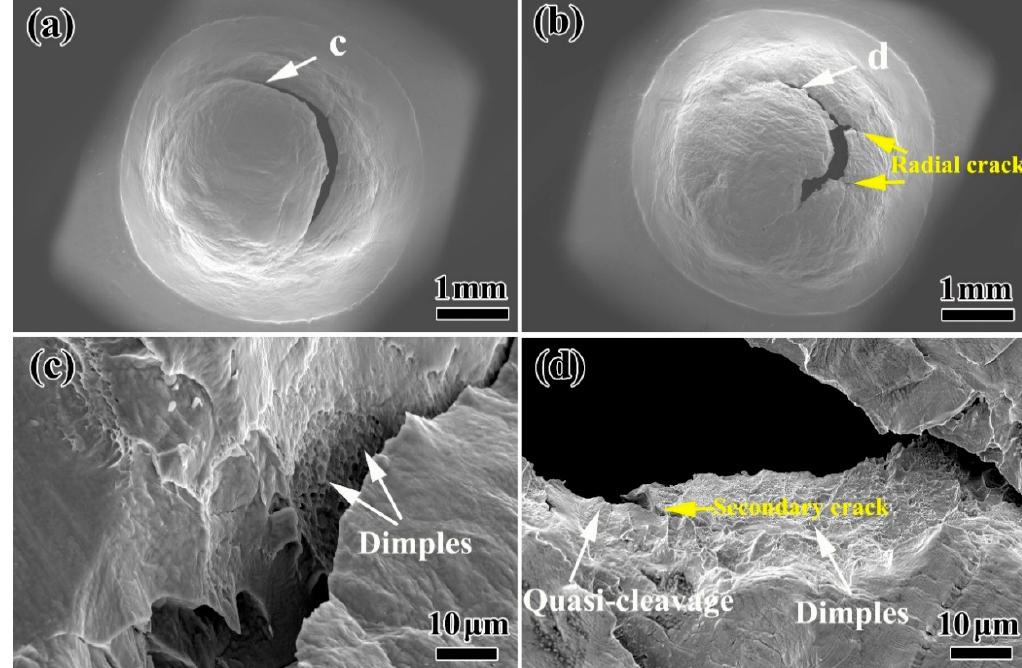
Figure 8. The overall SEM morphology of the small punch specimen after thermal aging for ( a ) 400 h and ( b ) 5000 h when the loading decreases by 80% of the maximum; ( c , d ) are the SEM morphologies of the corresponding positions in the white arrows ( a , b ).